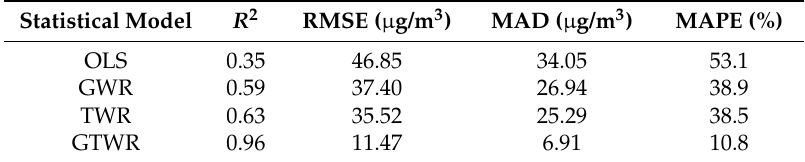
Table 2. Quantitative assessment of model fitting via OLS, GWR, TWR, and GTWR.